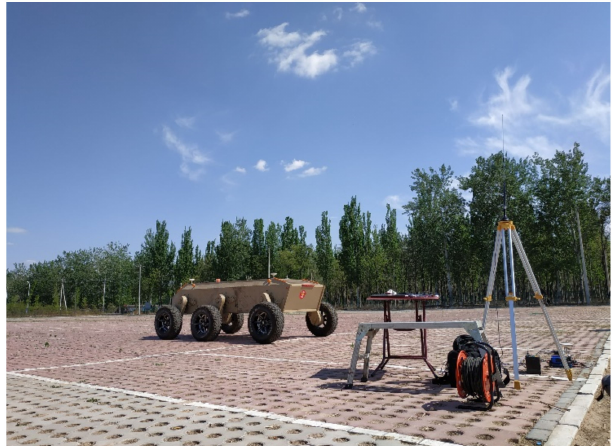
Figure 6. The experiment vehicle and RTK-GNSS base